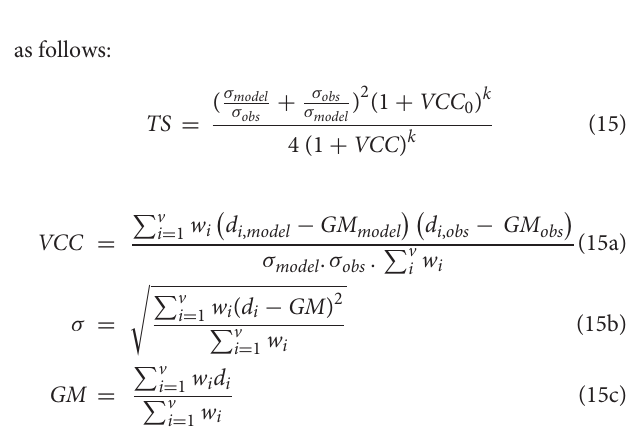
n p 1 , such that a i and b i are, respectively, the lower i = 1 ( b i − a i ) Q